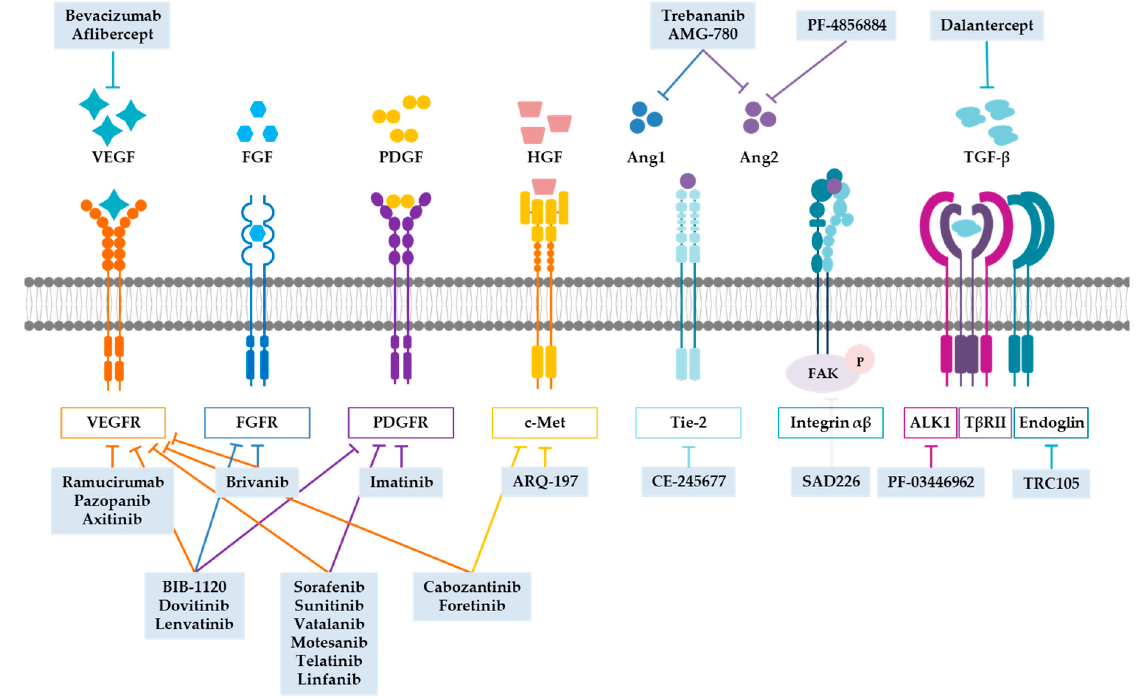
Figure 1. Main target signaling pathways of antiangiogenics. VEGF was the first signaling pathway inhibited by antiangiogenic drugs. Unfortunately, the benefits of anti ‐ VEGF/VEGFR are limited and patients develop resistance. Therefore, drugs were developed that inhibit alternative signaling pathways such as FGF and PDGF. Multikinase inhibitors (MKIs) simultaneously target different components of these pathways. HGF and its receptor c ‐ Met can also be inhibited by antiangiogenics. The angiopoietin pathway can be inhibited by preventing it traditional signaling through Tie2 or through integrins. There are also antiangiogenic drugs against TGF ‐β and its receptors ALK1 and endoglin.